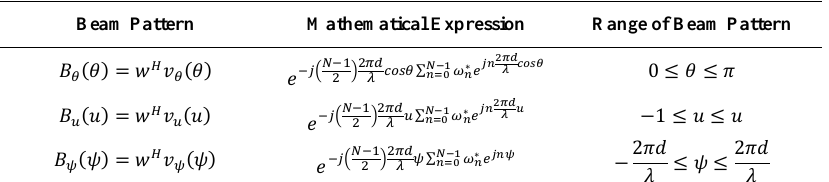
Table 5. Three Different Format of